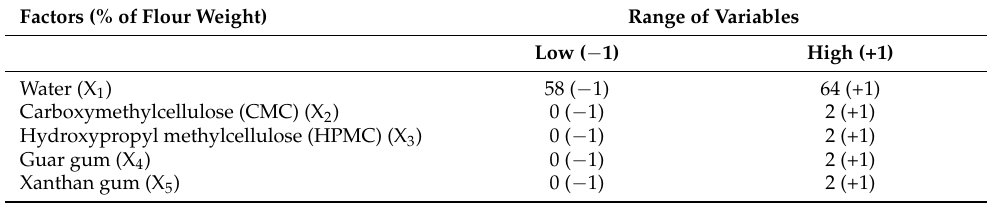
Table 1. Experimental and coded (between brackets) factors settings for the I-optimal design used. Factors (% of Flour